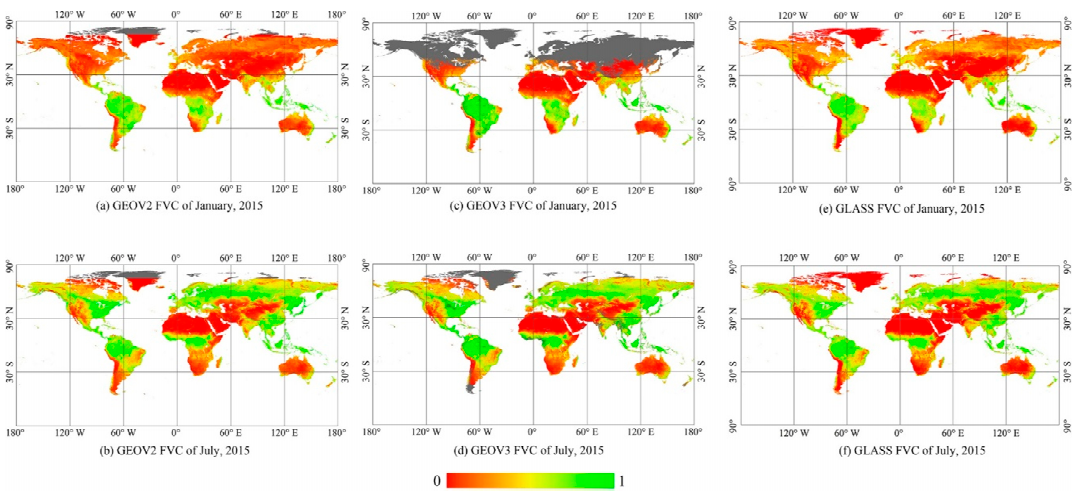
Figure 1. Monthly average global FVC maps from bioGEOphysical product Version 2 (GEOV2), bioGEOphysical product Version 3 (GEOV3), and Global LAnd Surface Satellite (GLASS) FVC products in January ( top ) and July ( bottom ), 2015.